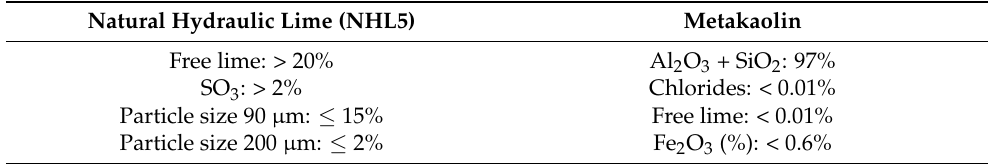
Figure 3. ( a ) Raman spectra of GO, rGO, and G-COOH and ( b ) Raman spectra of MWCNTs-COOH and MWCNTs-OSO 3 H.